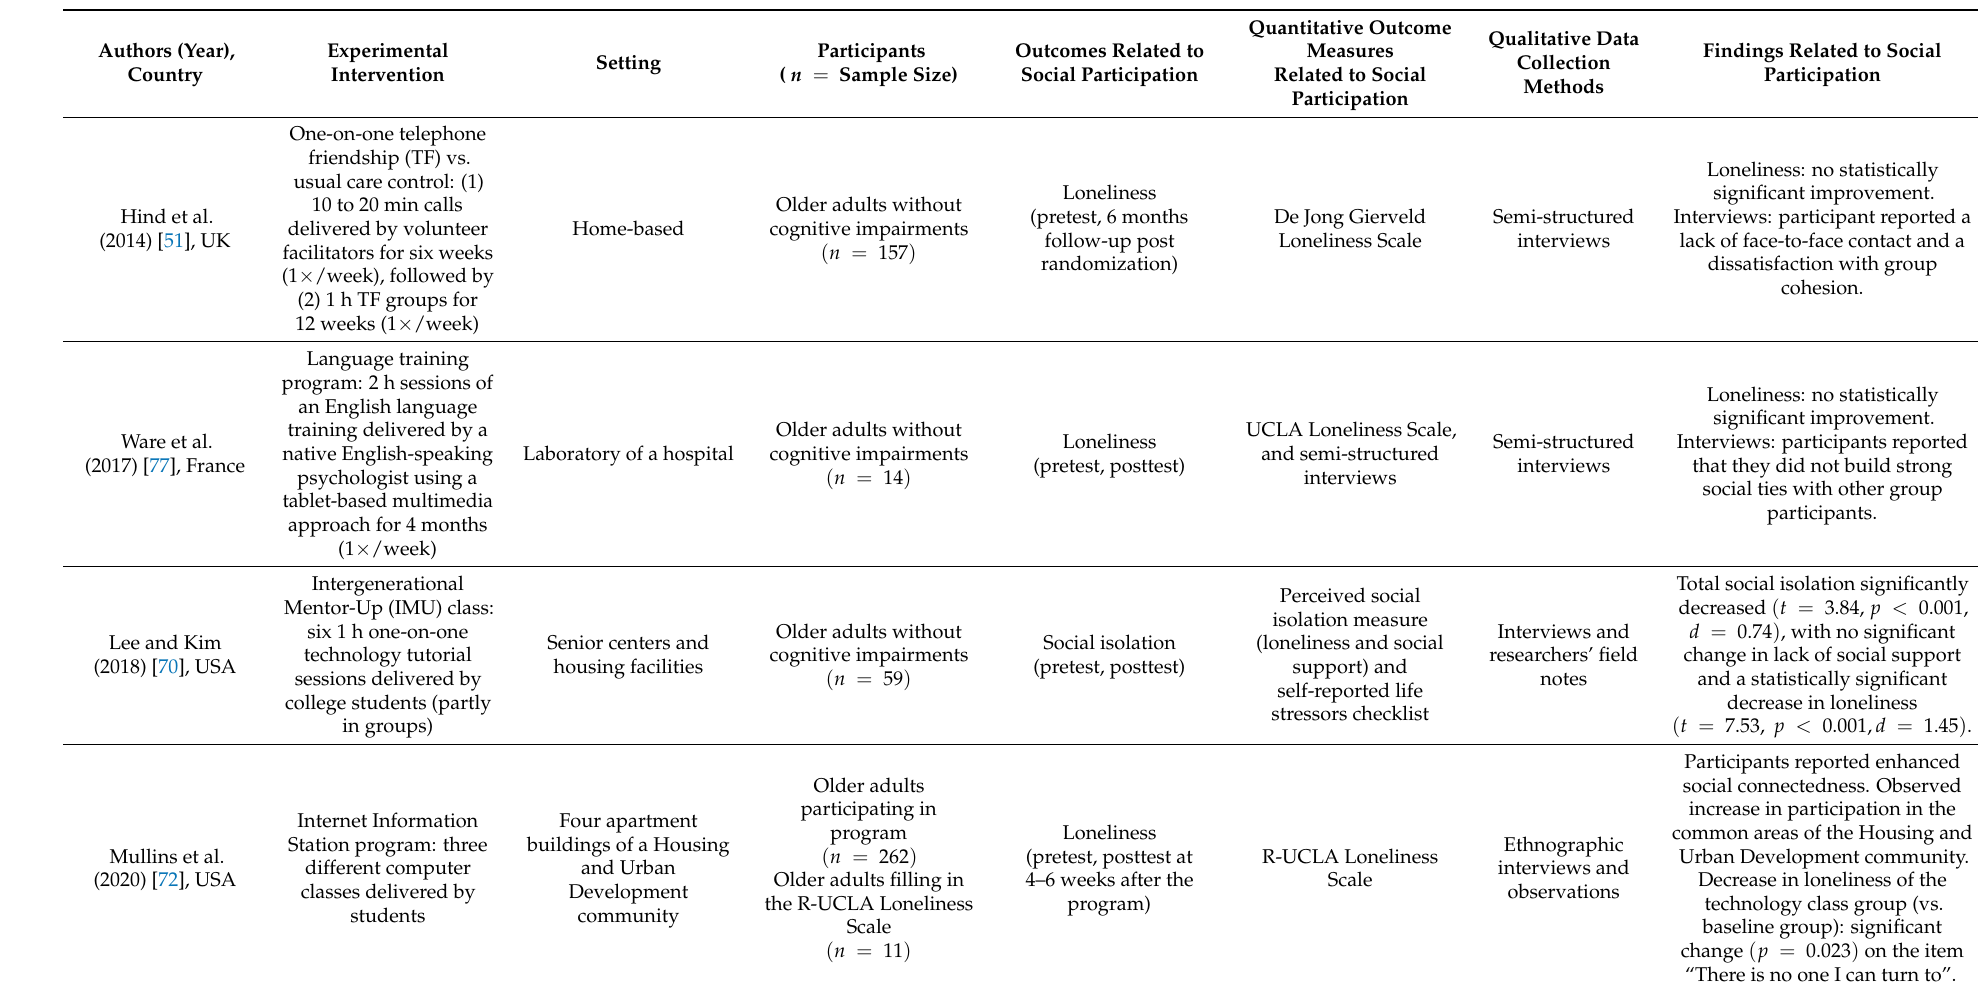
Table 7. Design, methods, and findings related to social participation reported from included mixed methods